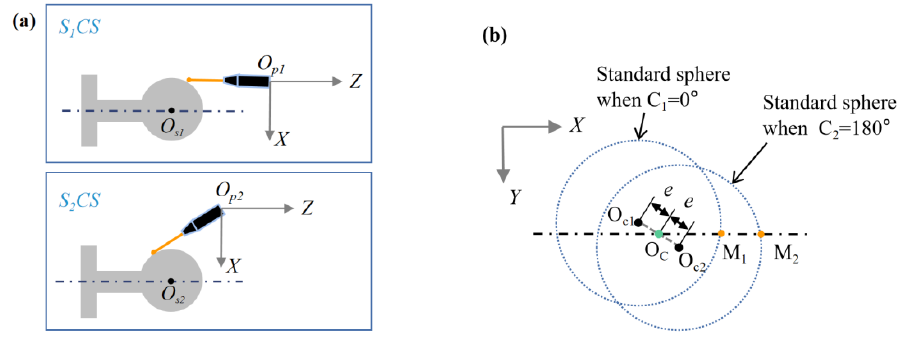
Figure 6. ( a ) Unifying two probe coordinate systems with the centered standard sphere. ( b ) Influence of the standard ball installation eccentricity.